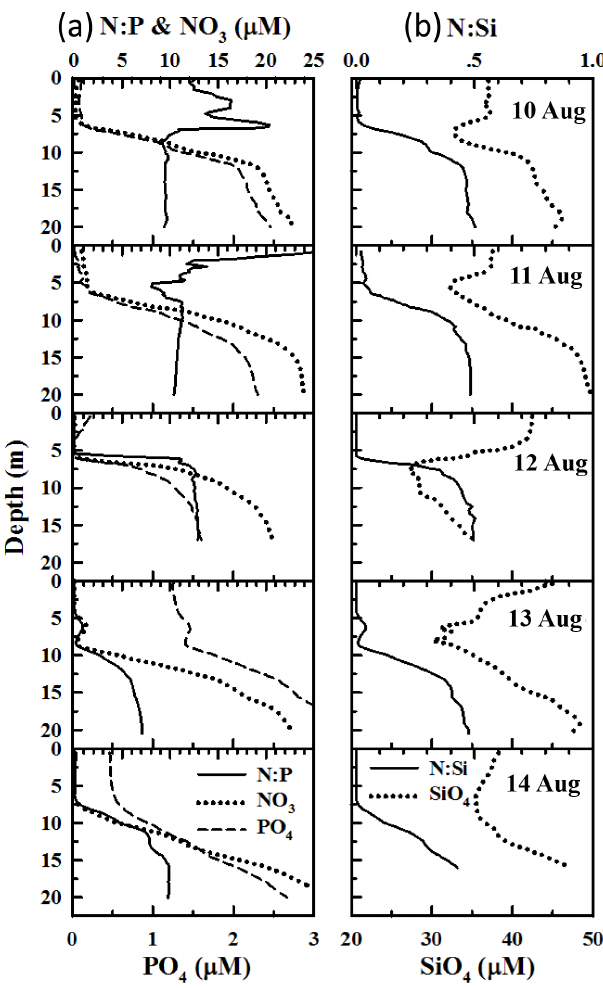
Figure 6. Vertical profiles in the time series at P5 during 10–14 Au- gust 1991. (a) NO − ratios.